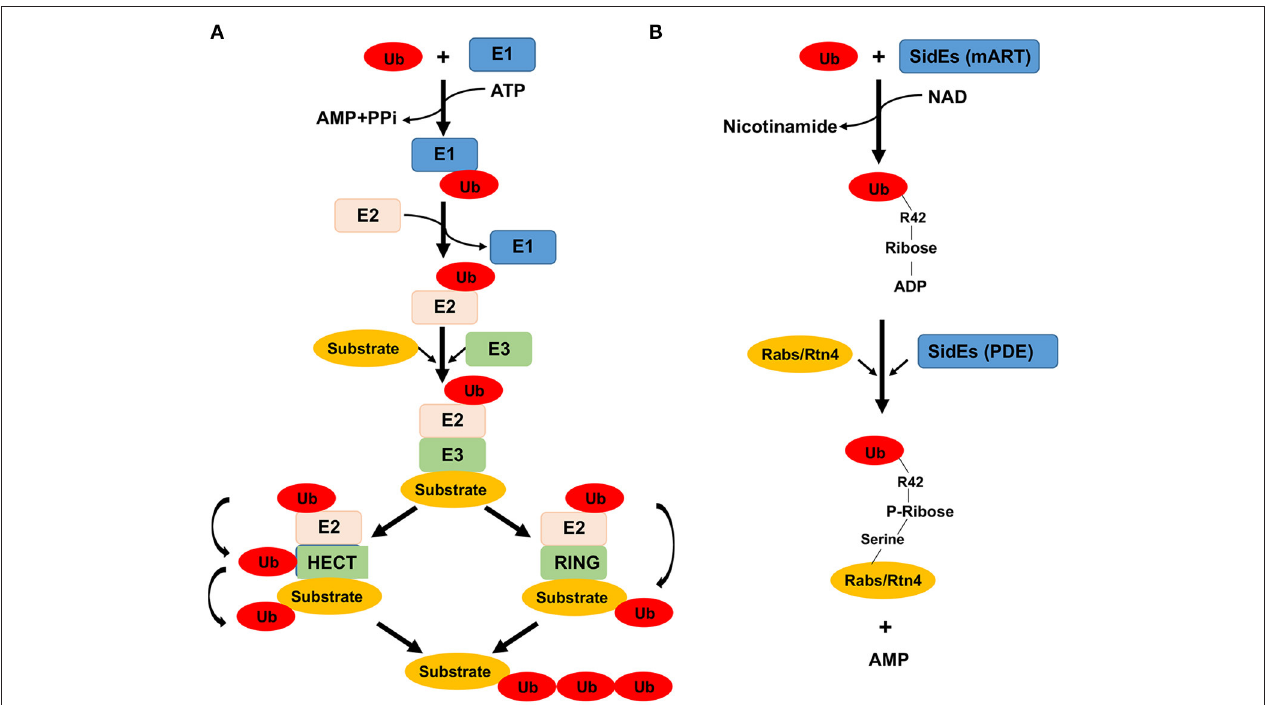
FIGURE 1 | Enzymes and chemical reactions involved in ubiquitination catalyzed by the canonical mechanism and by members of the SidE family proteins. (A) In the canonical mechanism, a ubiquitin molecule is activated by E1 at the expense of an ATP. The activated ubiquitin is first linked to E1 via a labile thioester bond prior to being transferred to the E2 conjugation enzyme, also linked by a thioester bond. The final step of the reaction differs greatly among different groups of E3 enzymes which dictate substrate specificity. For members of the HECT family of E3 enzymes (left), a reaction intermediate is formed, again by the formation of a thiolester bond between ubiquitin and E3, from where it is finally linked to lysine residues of the substrate. For other groups of E3 enzymes such as the RING family, the ubiquitin moiety is directly transferred to the substrate without the formation of an intermediate. (B) The reaction catalyzed by the SidE family begins with ubiquitin activation by ADP-ribosylation at Arg 42 to produce the reaction intermediate ADP-ribosylated ubiquitin (ADPR-Ub), a nicotinamide moiety is released in this step of the reaction. In the second reaction, ADPR-Ub is cleaved by a phosphodiesterase (PDE) activity also embedded in these proteins, resulting in the attachment of phosphoribosylated ubiquitin to serine residues of the substrate and the release of AMP. How ubiquitin is recognized by the mART motif is unknown, nor is the mechanism of substrate recognition presumably by the PDE